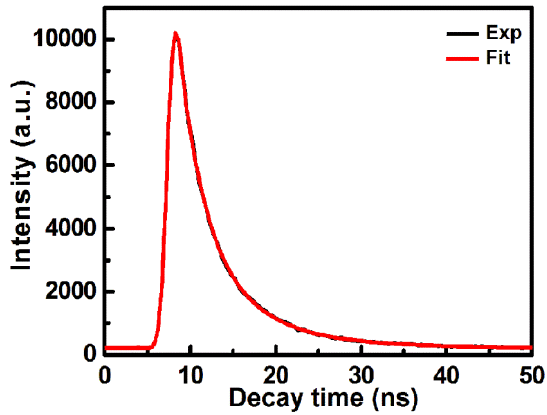
Figure 5. Time-resolved PL spectra of the CQDs-120. The average lifetime of CQDs-120 with two lifetime components (380 nm, decay time at 463 nm emission).